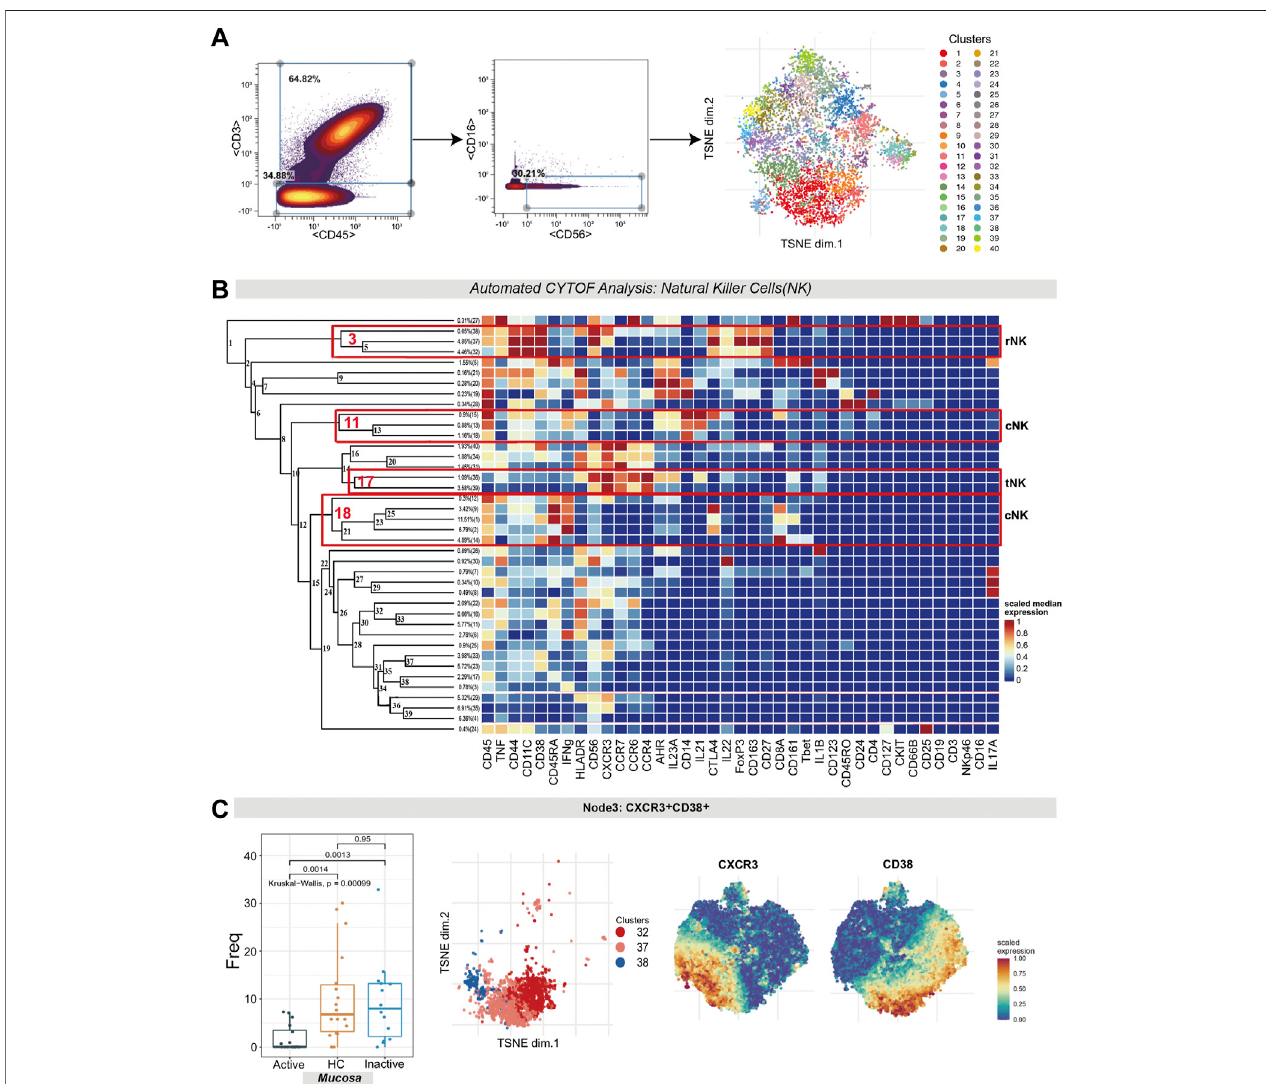
FIGURE6| NaturalkillercellanalysispointedoutthecontractionofCXCR3 + CD38 + regulatoryNKcellsinUCmucosa. (A) Gatingsteps(left)andt-SNEplot(right)of selected NK cells. (B) Cluster dendrogram, heatmap and selected nodes of NK cells. (C) Abundance boxplot and t-SNE plot of node 3 with CXCR/CD38 marker heatmaps for reference.